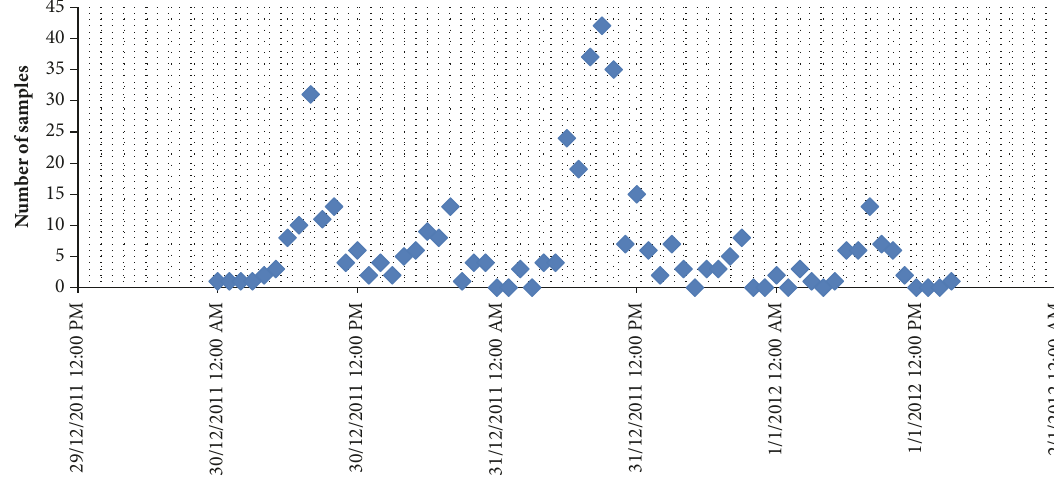
Figure 1: Departure date and time choice for intercity travel in New Year